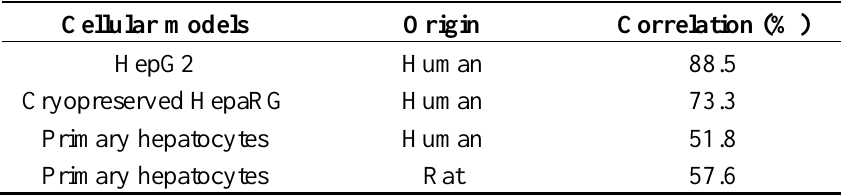
Table 1. Correlation between impedance and cell viability in different cellular models exposed to a set of 50 compounds. The cellular models, as indicated in table, were exposed to four concentrations of compounds in triplicate. Averages and correlation (%) were calculated with Excel software. For more details, please refer to the Materials and Methods